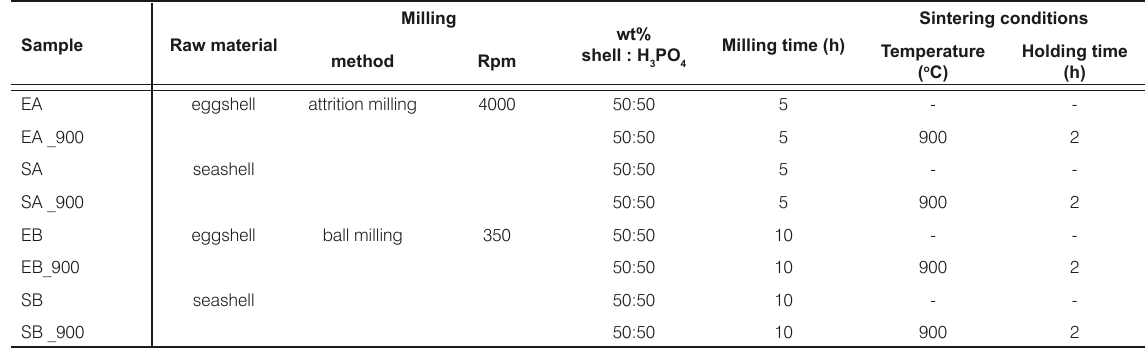
Table 1. Preparation parameters of